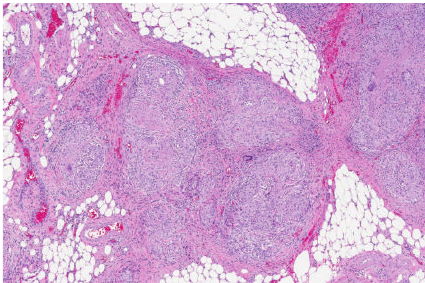
Figure 2: CT abdomen, moderate amount of abdominal, and pelvic ascites with diffuse thickening of peritoneal surfaces. Diffuse thickening also is seen throughout the omentum. Appearance is worrisome for peritoneal carcinomatosis.